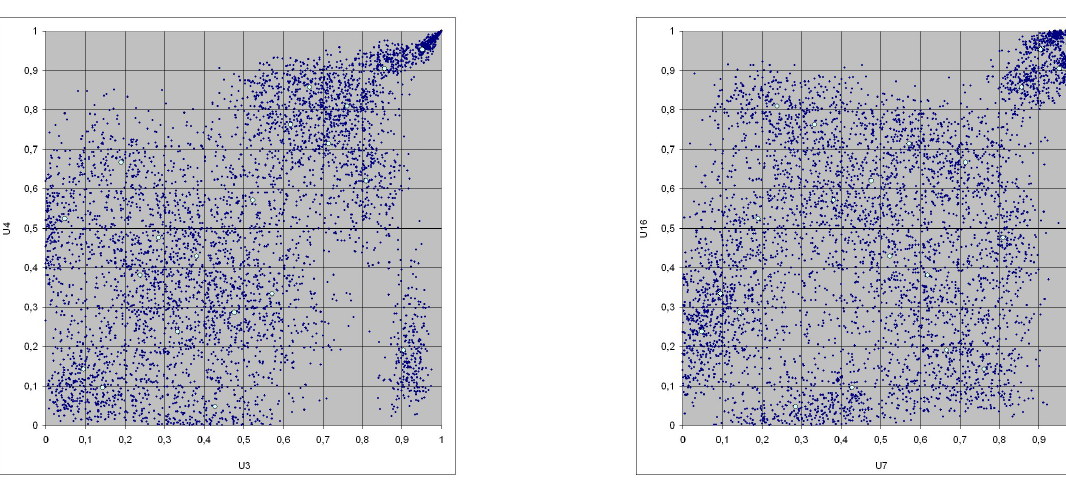
Figure 39: Gamma copula with UF copula driver,